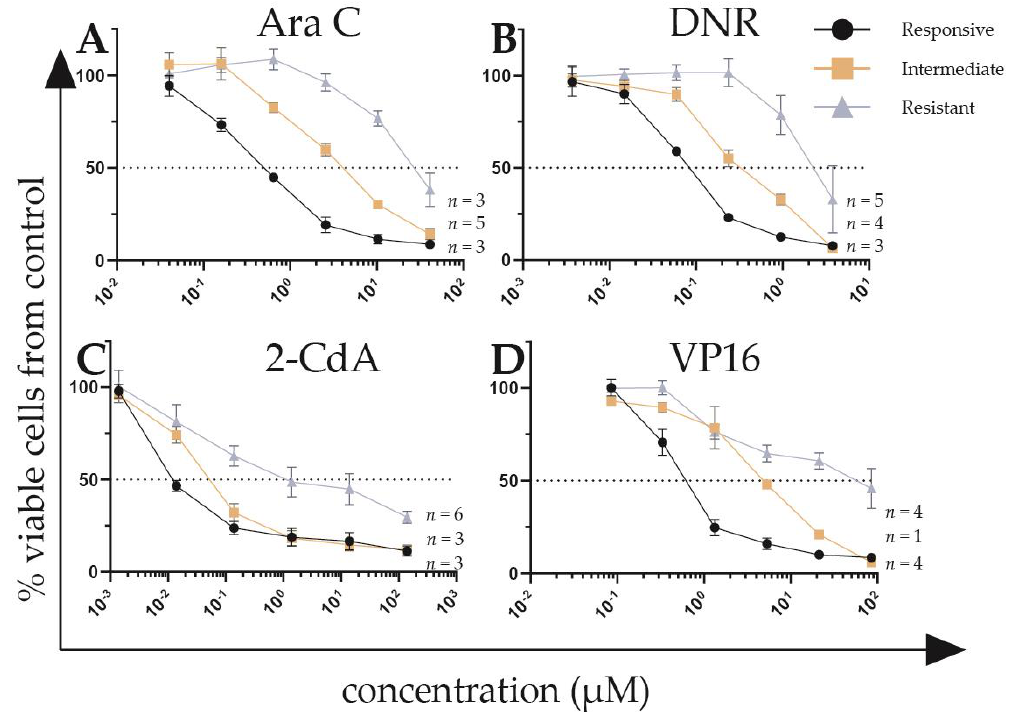
Figure 1. Representative dose-response curves for ex vivo drug response of primary acute myeloid leukemia (AML) samples towards ( A ) cytarabine (Ara C), ( B ) daunorubicin (DNR), ( C ) cladribine (2-CdA), and ( D ) etoposide (VP16). Responsive and resistant samples have LC 50 values below the 30th and 70th percentile, respectively. Error bars represent standard error of the mean. The number of samples visualized is displayed per response-group. Data from each patient sample was assessed using technical duplicates.